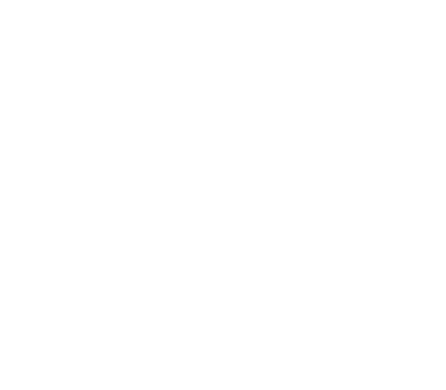
Table 20. Coordinate data of the measuring point of the advanced hydraulic